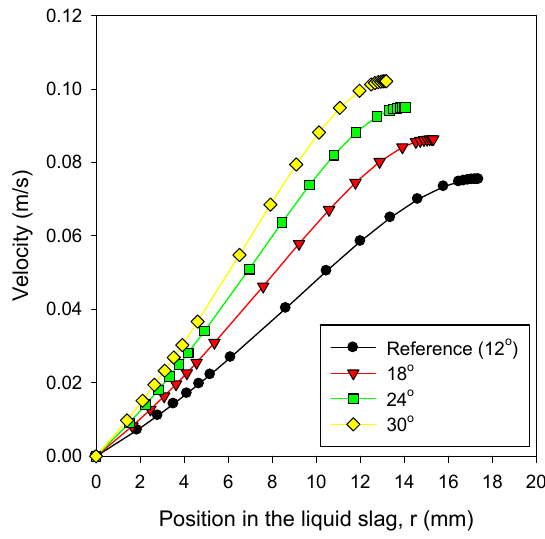
Figure 7. Effects of bottom cone angle on velocity distribution of liquid slag at the slag